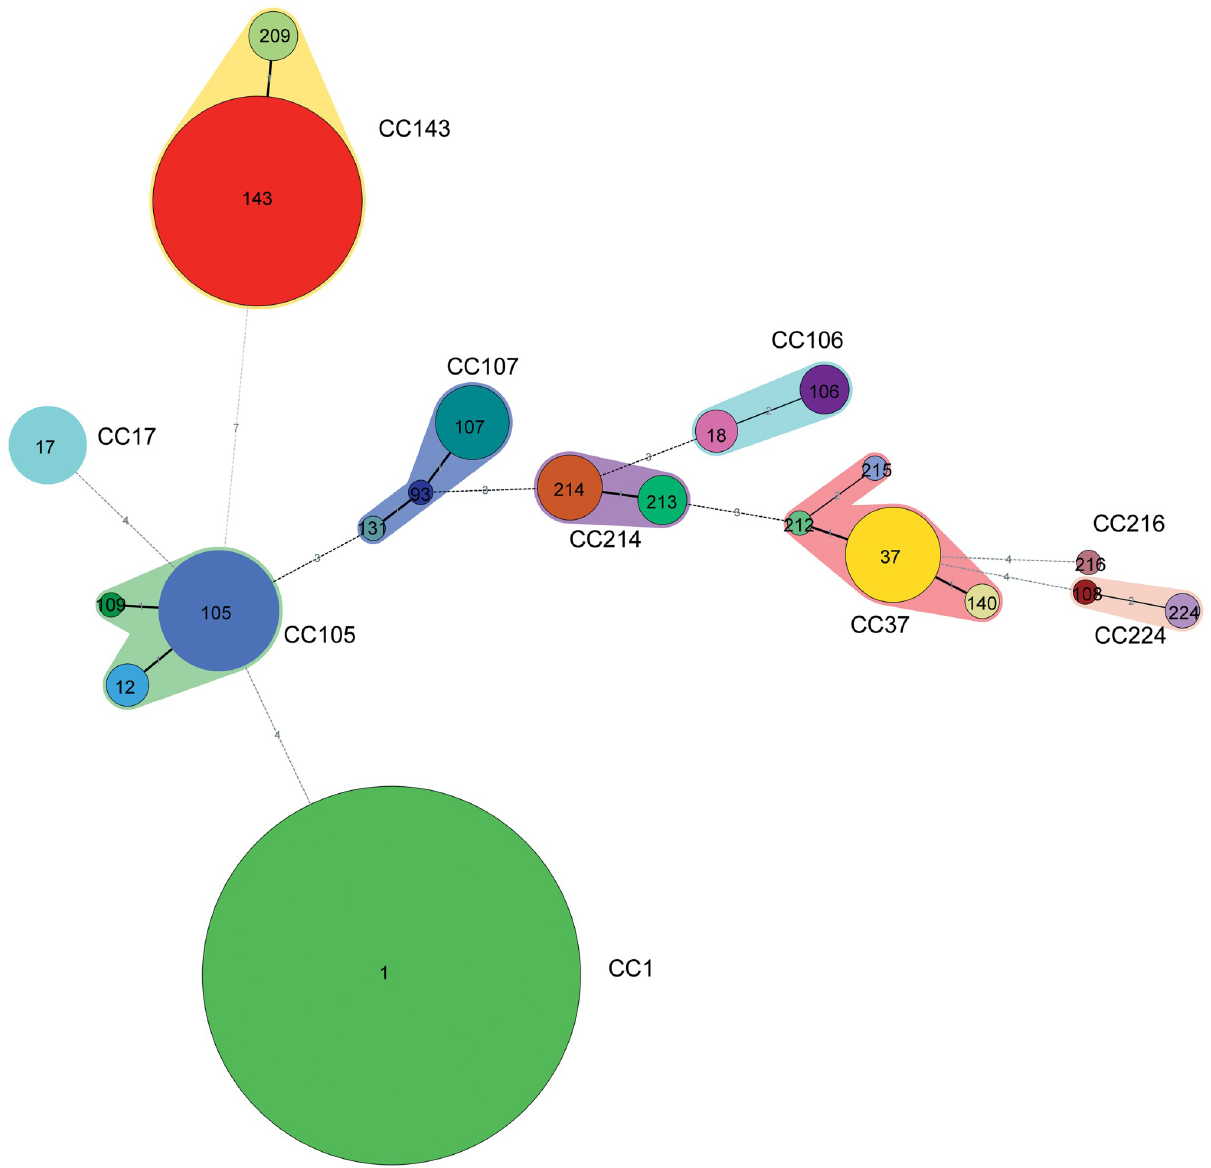
Fig 2. Minimum spanning tree analysis of 401 pathogenic Leptospira strains of Jiangxi. The size of the circle is proportional to the number of strains and the color indicates the diverse serogroup. The digits on the lines between two circles represent the different number of two STs. The shading surrounding the STs simply links STs within the same clonal complex (CCs). Ten CCs including (CC143, CC105, CC37, CC107, CC214, CC106, CC17, CC1, CC216 and CC224) were